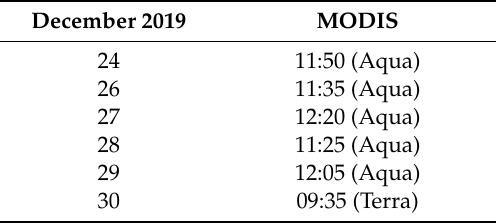
Table 2. MODIS images considered for the SEVIRI ash and SO 2